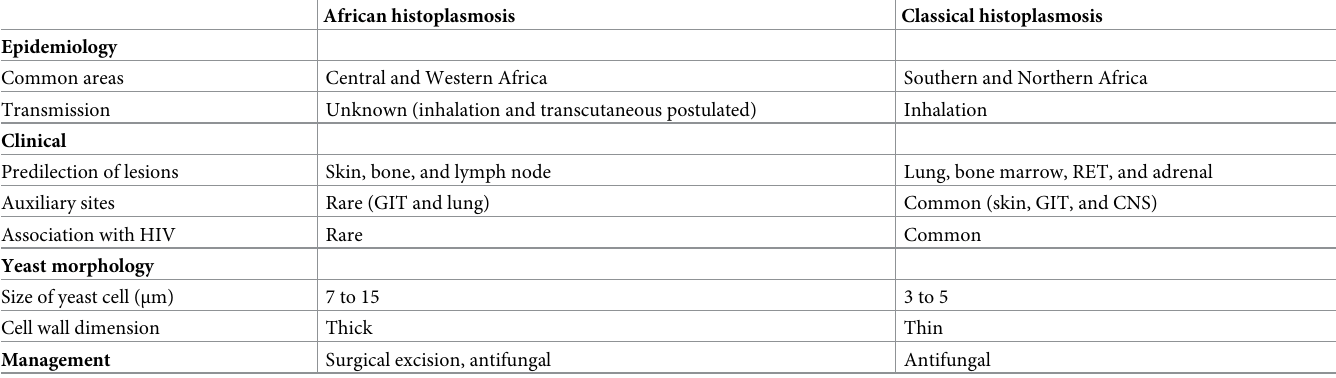
Table 1. Comparison of epidemiological, clinical, and laboratory characteristics of African and classical